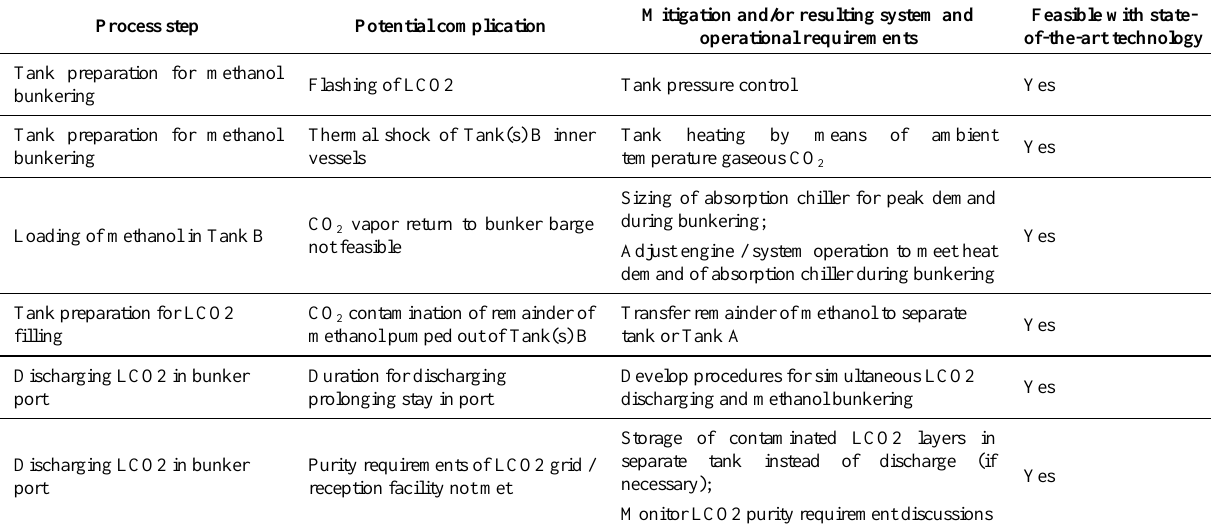
Table 2. Mitigation measures for combined methanol / CO2 tank systems